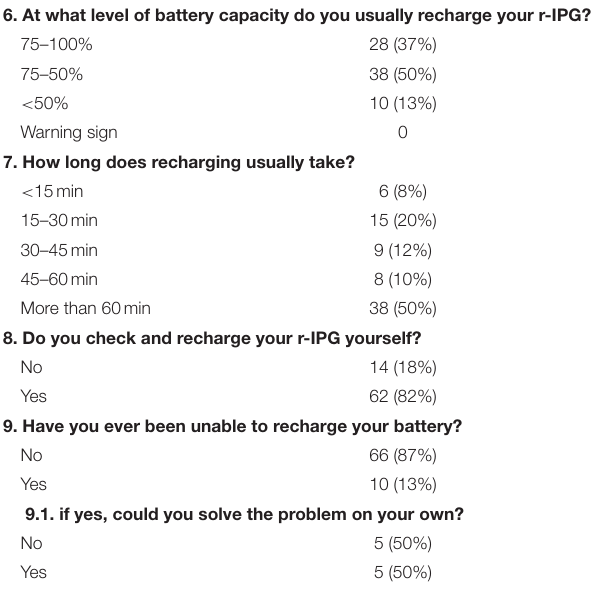
TABLE 4 | Recharging process for patients with rechargeable implanted pulse generators (r-IPGs) ( N = 76) (Question 6–9). 6. At what level of battery capacity do you usually recharge your r-IPG?